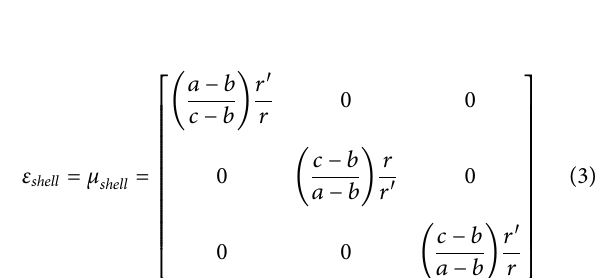
FIGURE 3 | Schematic plan for a cylindrical sample with radius d . ε sample and μ sample are the CP of the object that placed in core medium of expander and illuminated by